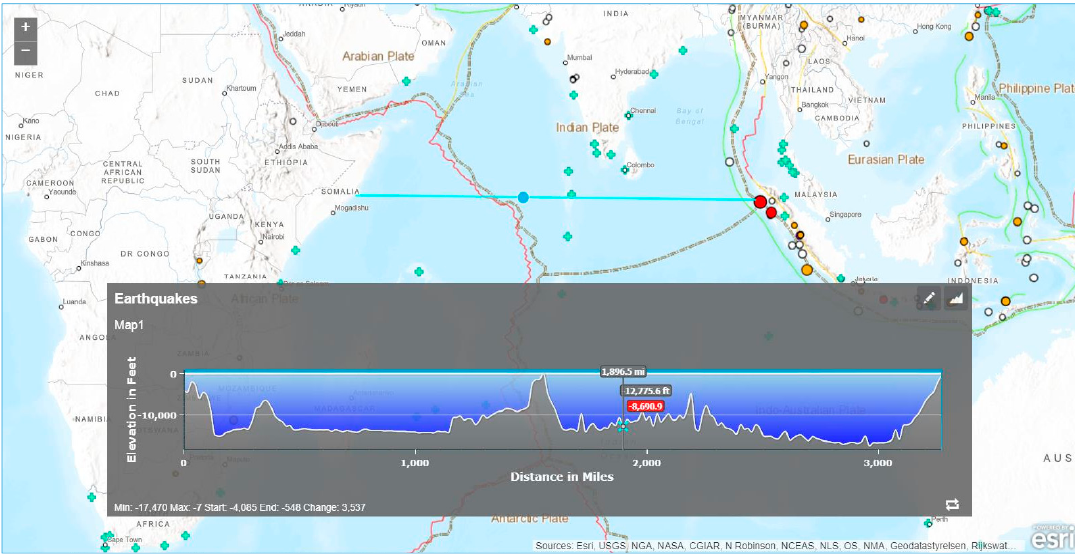
Figure 7. Exploring the shape of the ocean floor.